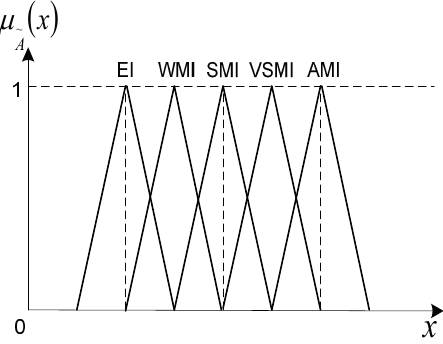
Figure 4. Linguistic scale for relative importance. EI, equal importance; WMI,